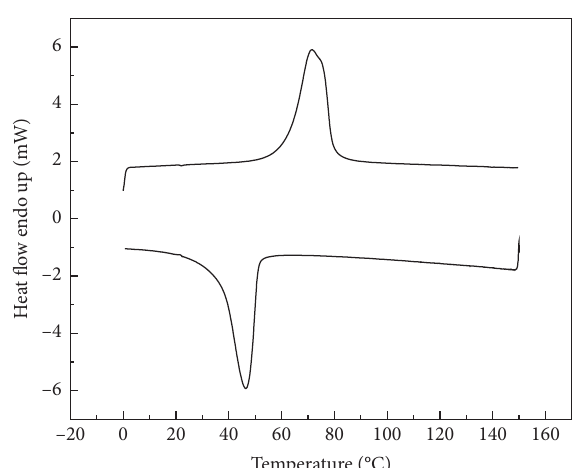
Figure 6: DSC phase transformation curve after thermodynamic treatment.